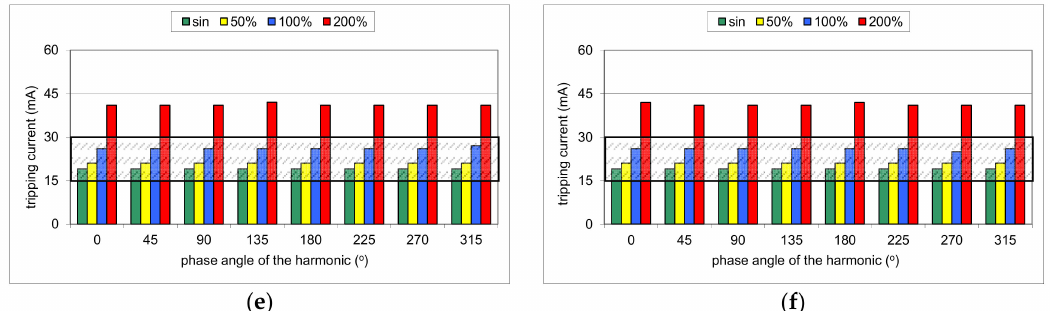
Figure 8. Tripping current of the A-type 30 mA RCD (no. RCD30_1) for testing waveform comprising